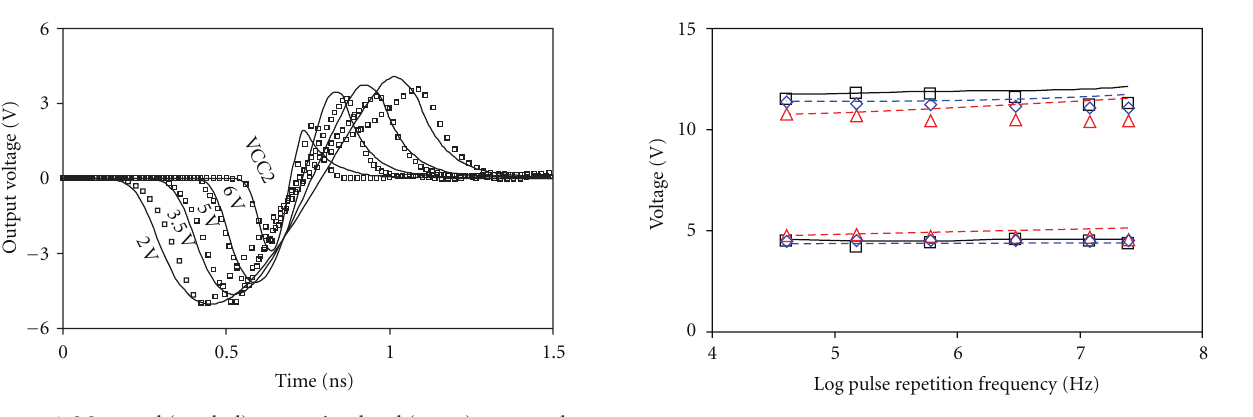
Figure 8: Measured (symbol) versus simulated (curve) monocycles generated with VCC1 = 3.3V, VCC2 = 2–6V, and VCC3 = 13 V.